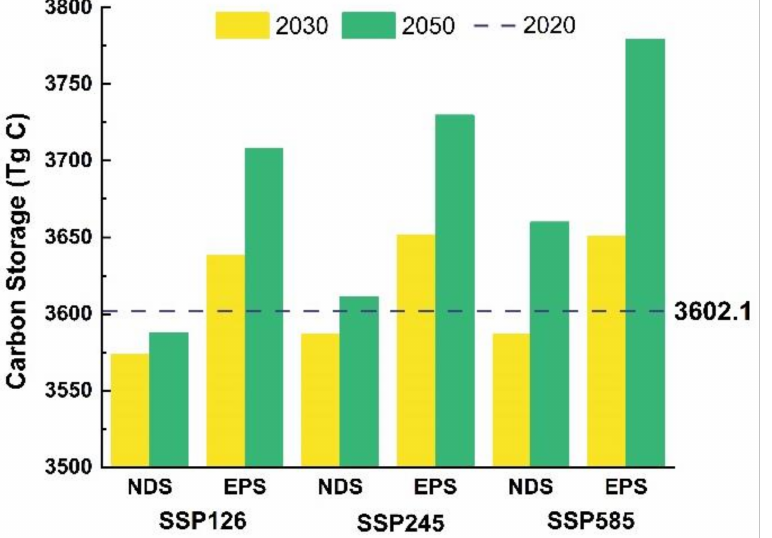
Figure 10. The carbon storage in the future periods (2030 and 2050) under the LUTC Scenarios (NDS and EPS) and Future Climate Scenarios (SSP126, SSP245 and SSP585) in Gansu